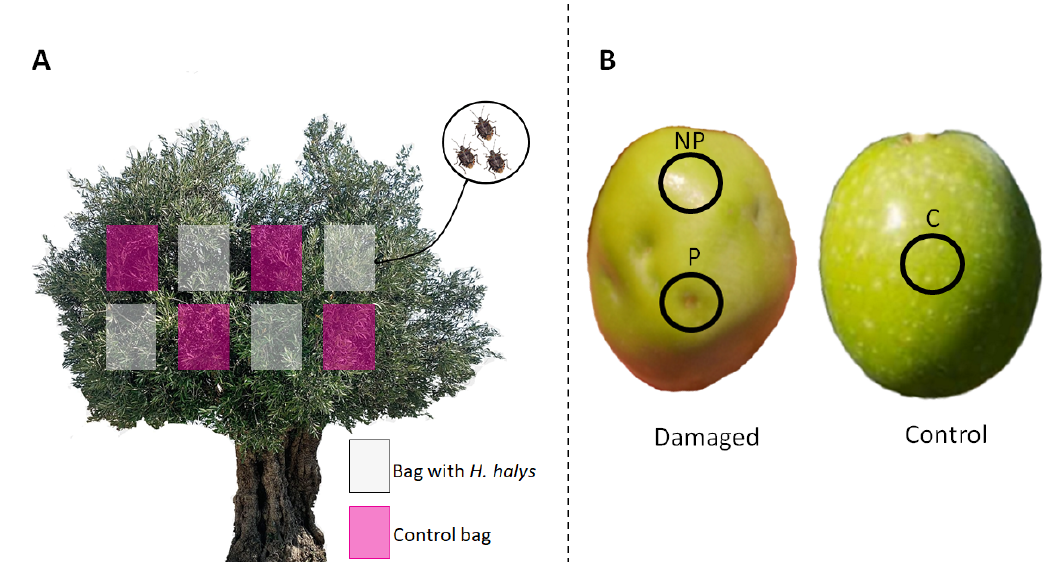
Figure 1. Visual concept of the study. On each tree, four net bags with three adult H. halys individuals and four net bags without insects were placed ( A ). Method of fruit tissues cutting from control (right) and damaged fruits (left) ( B ).